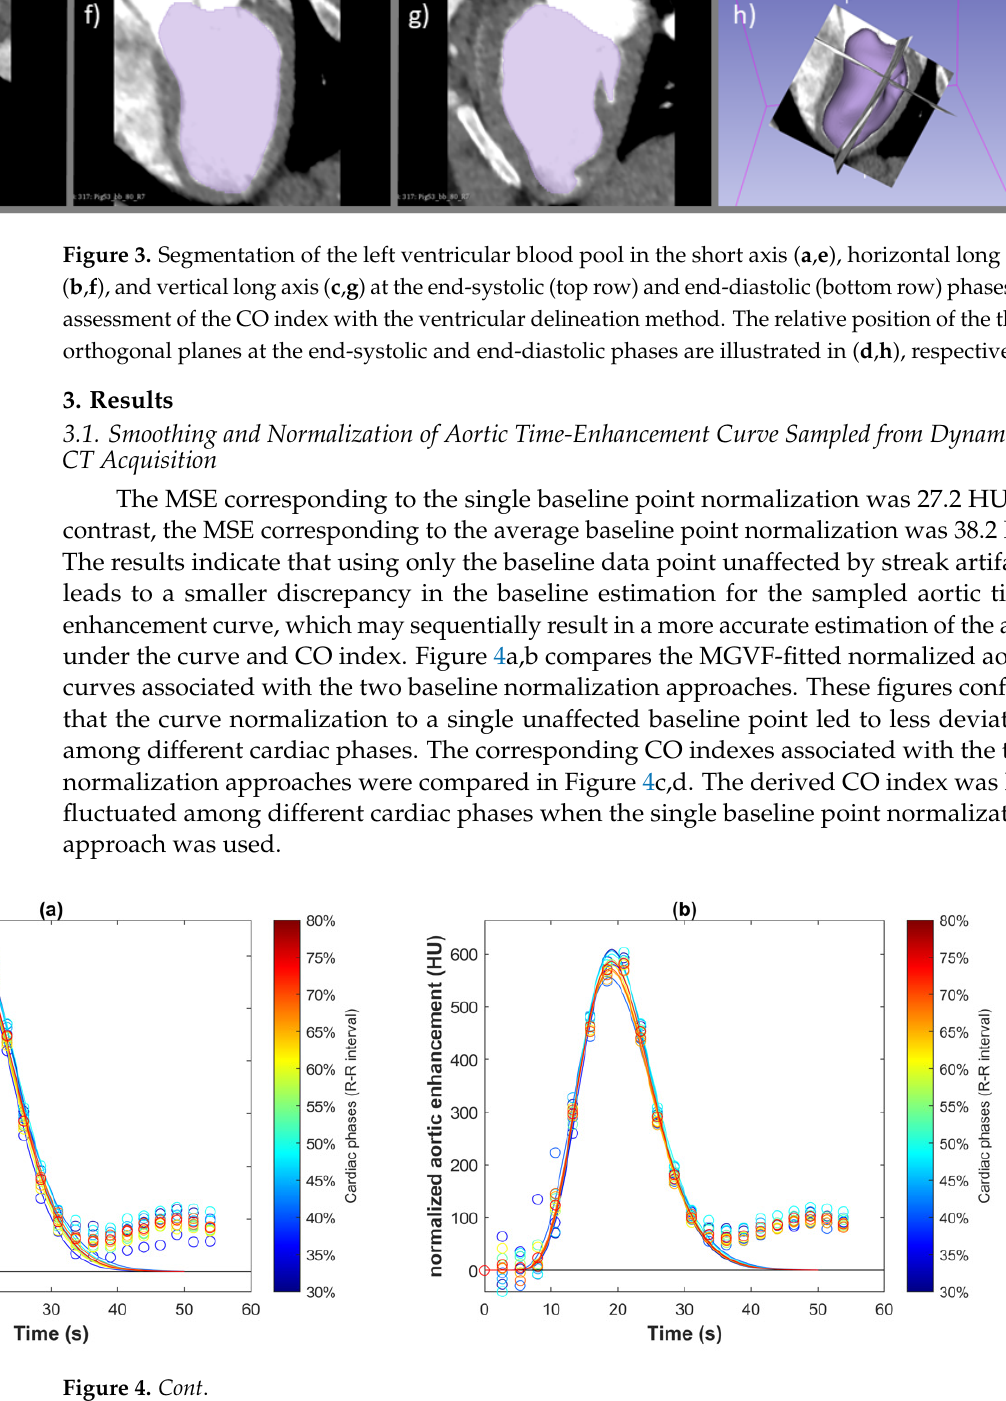
Figure 4. Two curve normalization approaches for assessment of CO index in a pig study—baseline subtraction using ( a ) the averaged value of all baseline data points and ( b ) only the baseline data point unaffected by streak artifacts. The curves shown in ( a , b ) were acquired from a pig at different cardiac phases, ranging from 30% to 80% of the R ‐ R interval, with each cardiac phase represented by a color illustrated in the color ‐ coded bar adjacent to the graphs. The estimated CO indexes cor ‐ responding to the two curve normalization approaches are shown in ( c , d ), respectively. The CO indexes estimated with the second normalization approach among different cardiac phases were less deviated from each other. 3.2. Effect of Cardiac Phase on CO Index Derived from Indicator Dilution Method The boxplots in Figure 5 depict the integral of the aortic time ‐ enhancement curve and the CO index in the 17 CT myocardial perfusion studies at each cardiac phase using the single baseline point normalization and indicator dilution method. The mean and stand ‐ ard deviation of the integral of the aortic curve among different cardiac phases were 0.228 ± 0.001 HU (cid:3401) s. The mean and standard deviation of the CO index among different cardiac phases were 4.031 ± 0.028 L (cid:3401) min − 1 . There were no statistically significant differences in either the integral of aortic curve or CO index among different cardiac phases ( p > 0.05 for all cardiac phases).